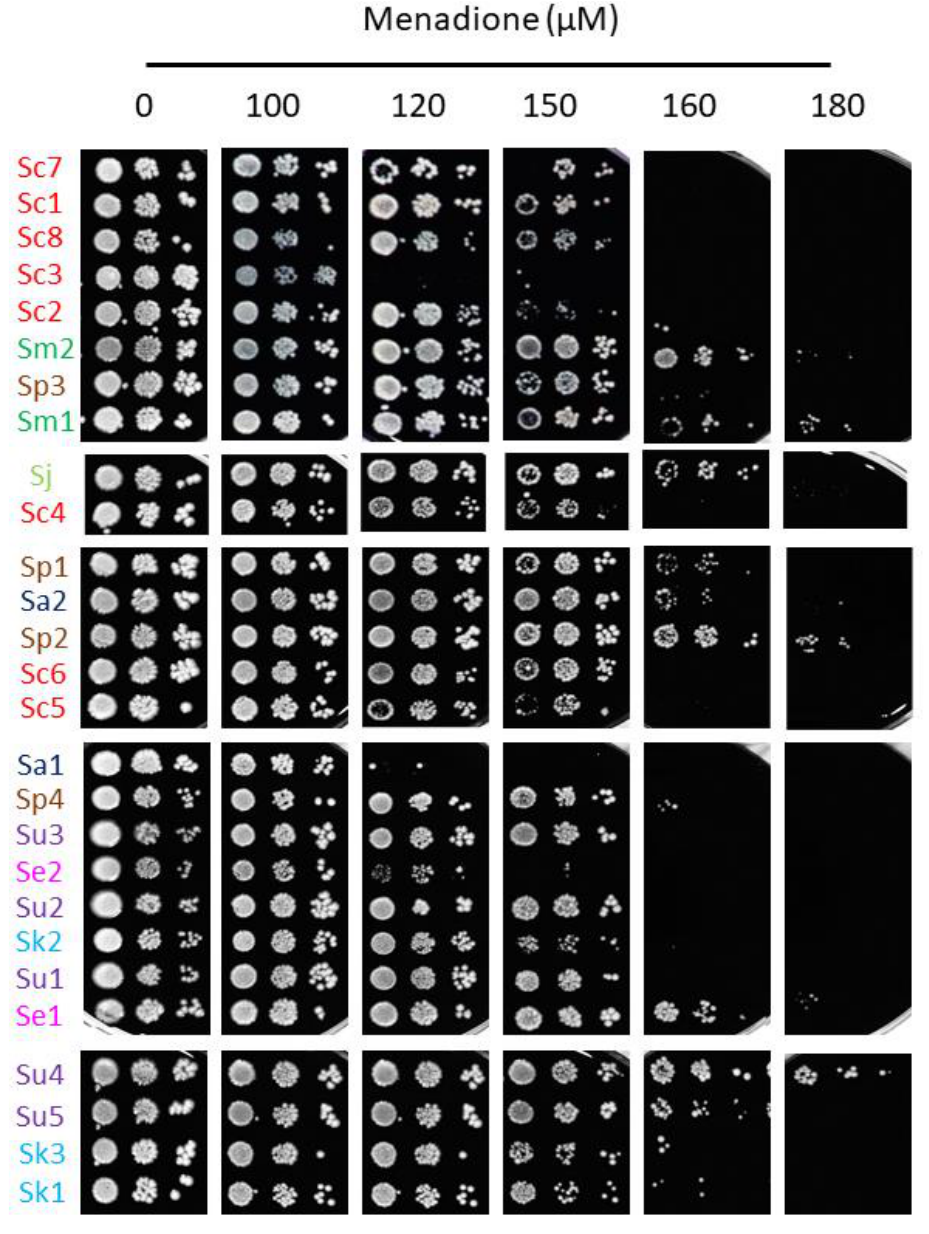
Figure 6. Growth of Saccharomyces strains in the menadione-containing media. Yeasts were cultivated and assayed for growth, as depicted in Figure 5, but on SC plates with the indicated range of menadione concentrations.